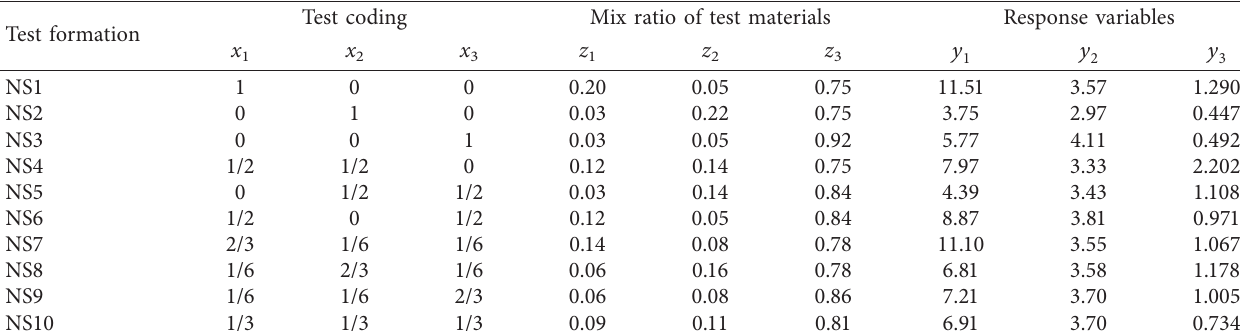
Table 6: Axis point extended simplex lattice design and the result of lower limit component boundary in mixed cement and gravel modified with raw soil.